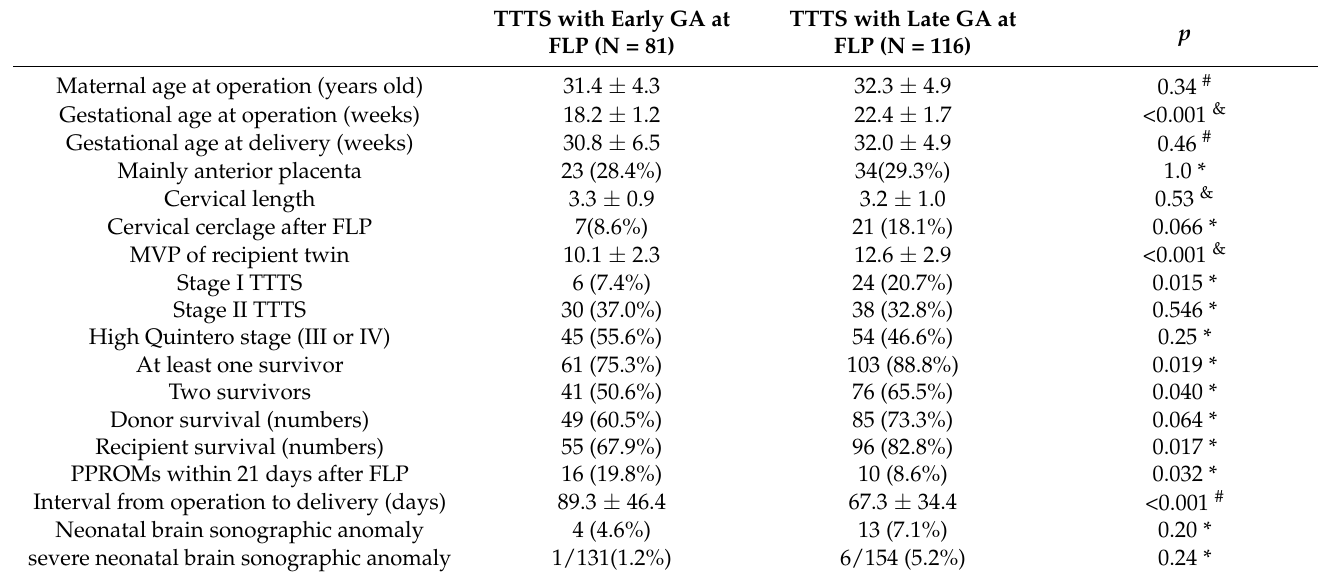
Table 2. Characteristics of patients with twin–twin transfusion syndrome with an early gestational age ( ≤ 20 weeks) and late gestational age (>20 weeks) at the time of fetoscopic laser therapy. TTTS with Early GA at FLP (N = 81)